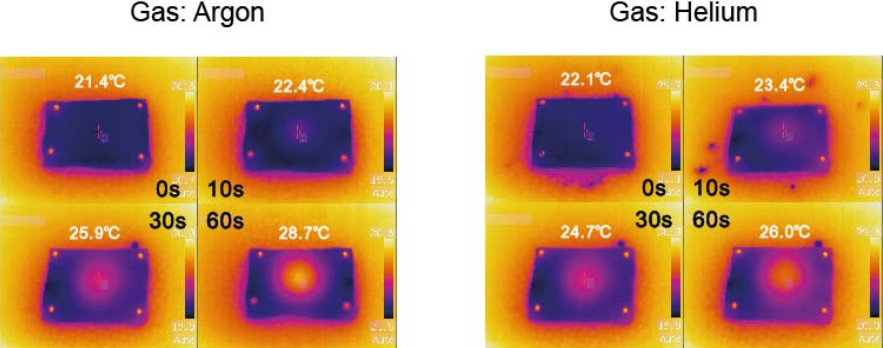
Figure 6. Temperature on porcine skin surface by argon and helium plasma irradiation for 0, 10, 30 or 60 s at a distance of 4 mm between the plasma jet and the surface of the skin.